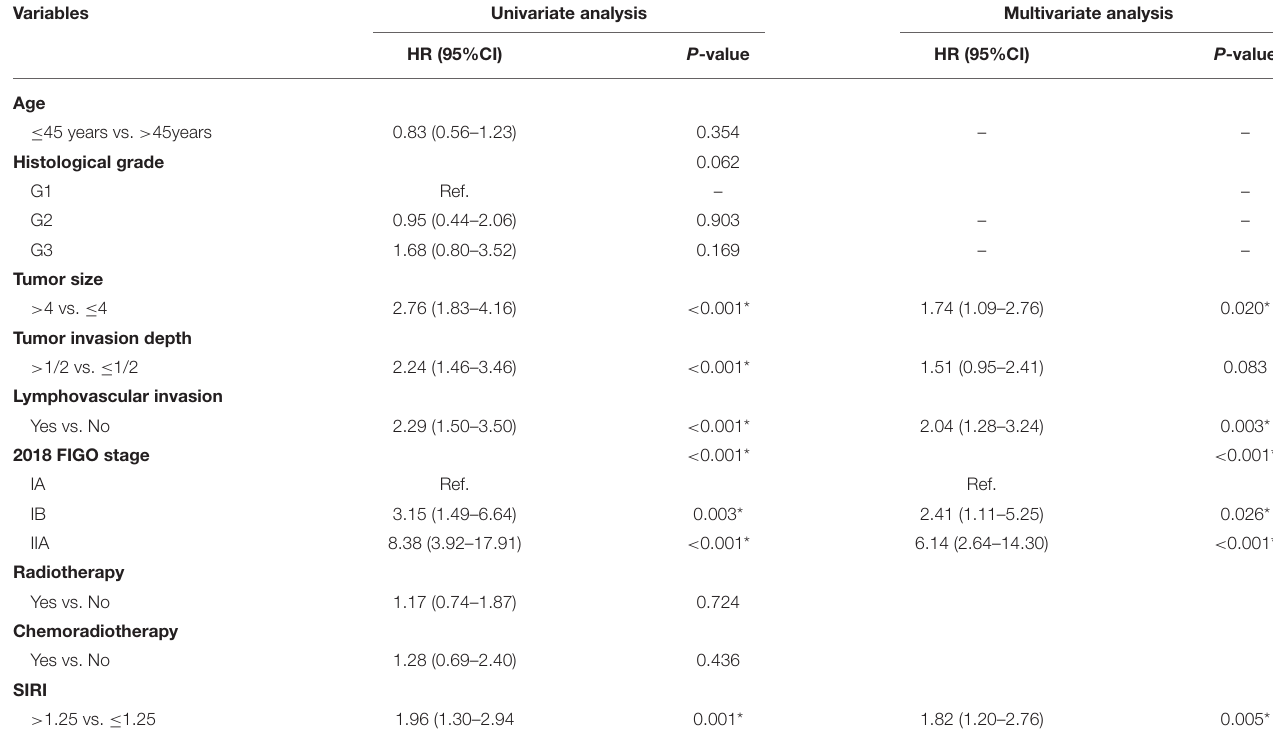
FIGO, International Federation of Gynecology and Obstetrics; SIRI, systemic inflammation response index; HR, hazard ratio; CI, confidence interval; Ref, reference. * Statistically significant (P < 0.05).